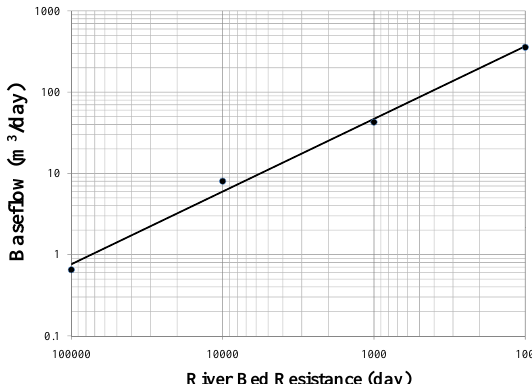
Fig. 9. Groundwater and surface water interactions in the Kings Creek watershed and their dependence upon the streambed properties. which is dry most of the year (Dodds et al., 1996). These 445 figures illustrate conditions when resistance is 100,000days.